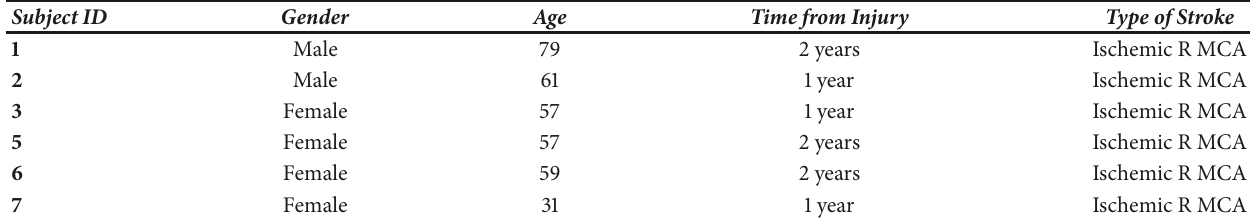
Table 1: Subject demographics.